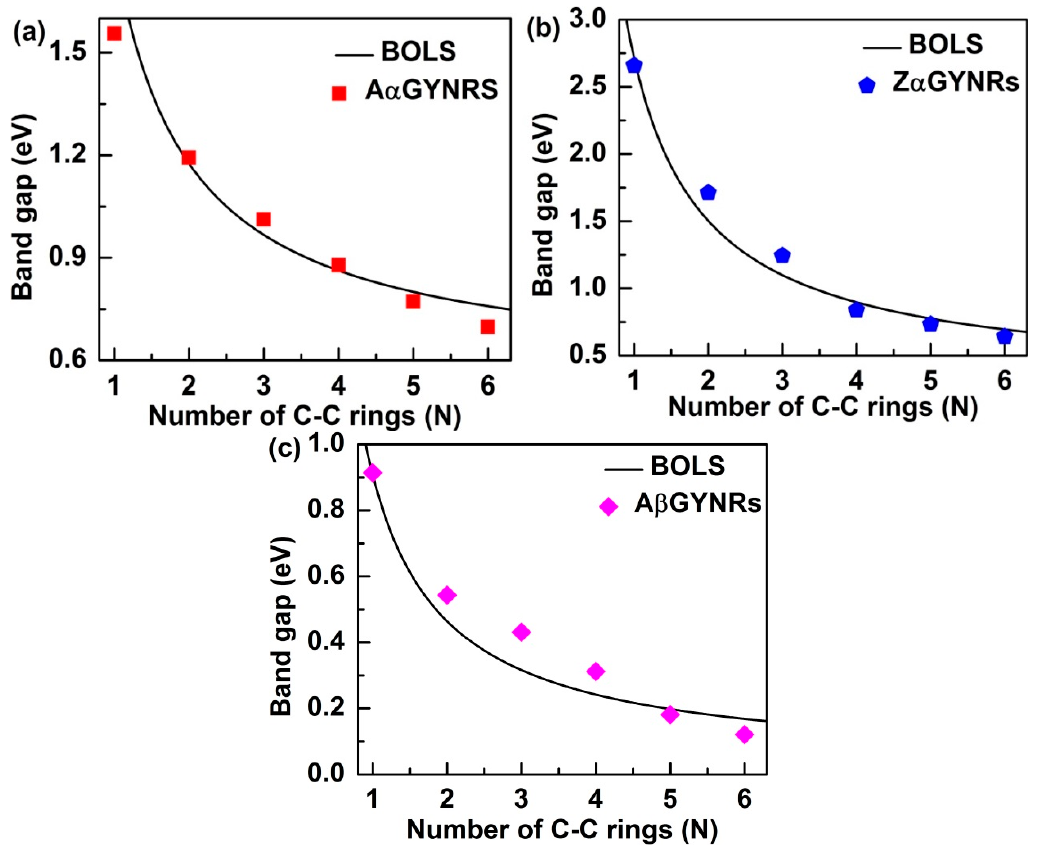
Figure 7. Comparison of the calculated size effect in GYNRs between ab initio and BOLS with ( a ) armchair- and ( b ) zigzag-edged α -GYNRs, as well as ( c ) armchair-edged β -GYNRs.